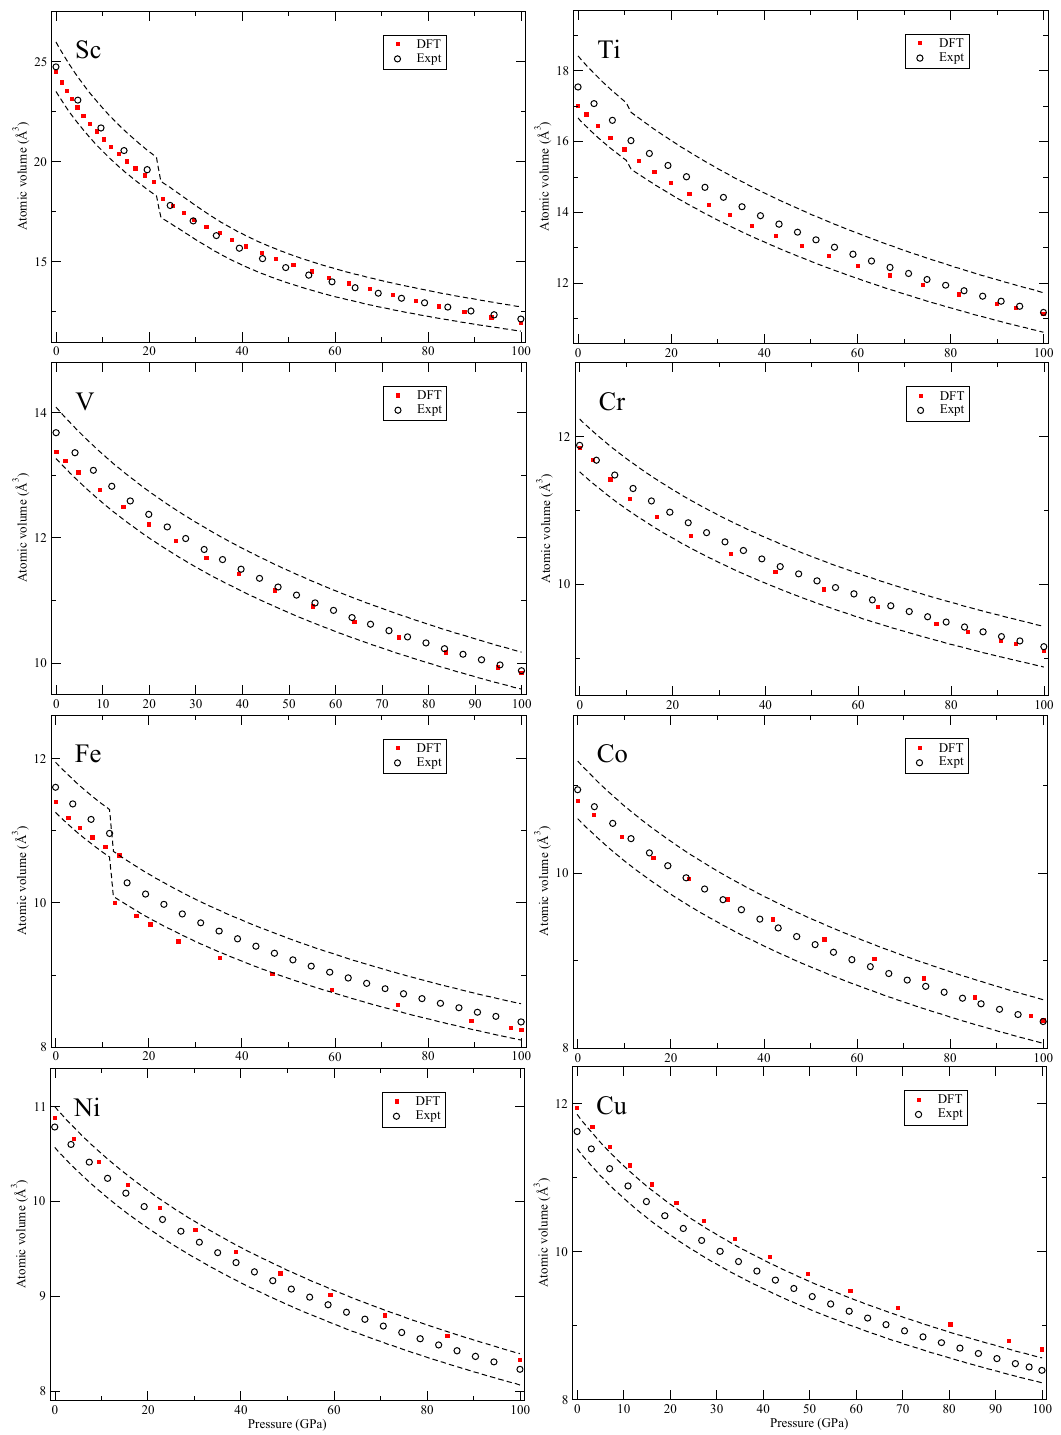
Figure 3. Experimental and DFT EOS for Sc, Ti, V, Cr, Fe, Co, Ni and Cu.